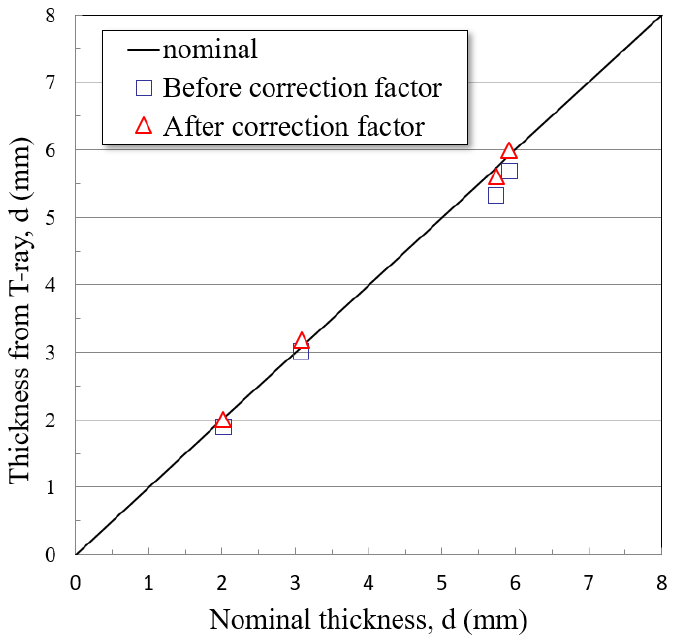
Figure 10. The relation between the nominal thickness and the thickness measured from the T-ray techniques in the GFRP composites.